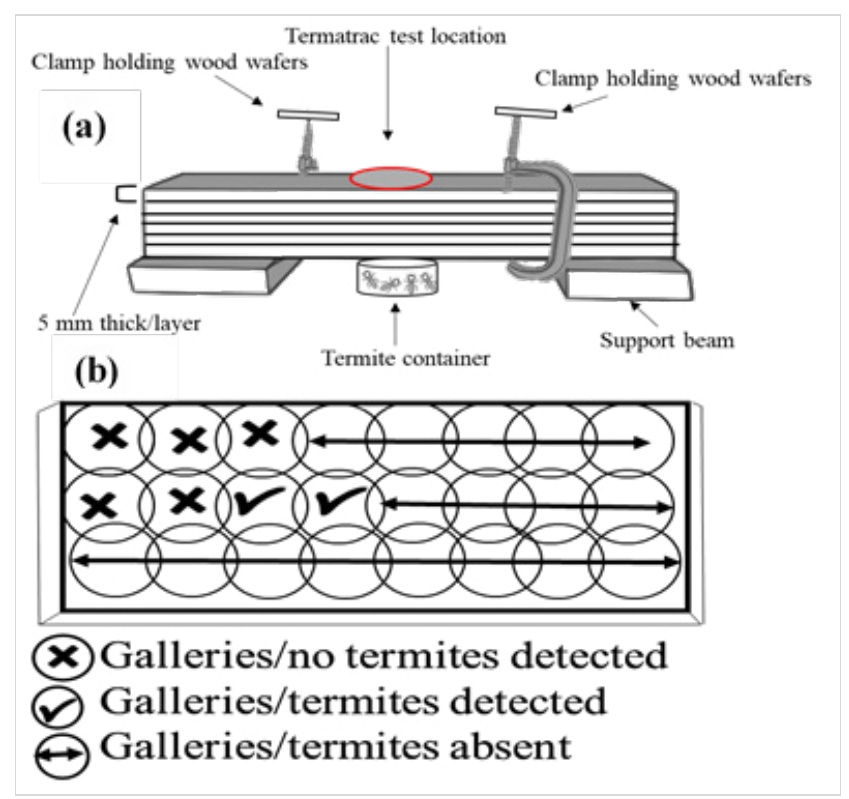
Fig 1. Setup used to determine detection depth and effect of C. brevis number on device signal strength (a) (side view) and an example of the sampling pattern on a naturally infested board used to determine depth detection showing presence (√) and absence (X) of C. brevis in different sections (b) (top